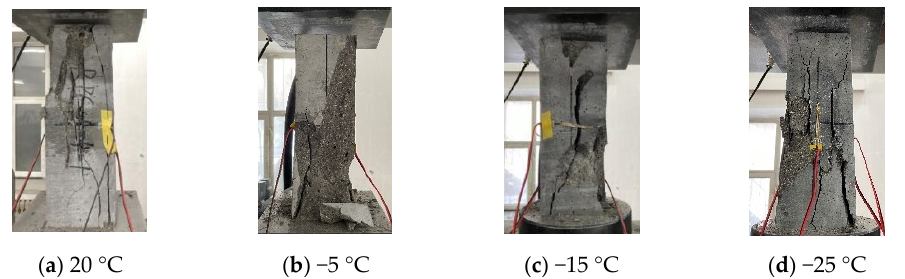
Figure 8. Compression failure modes of CFRPC3 prismatic specimens after different exposure temperatures.